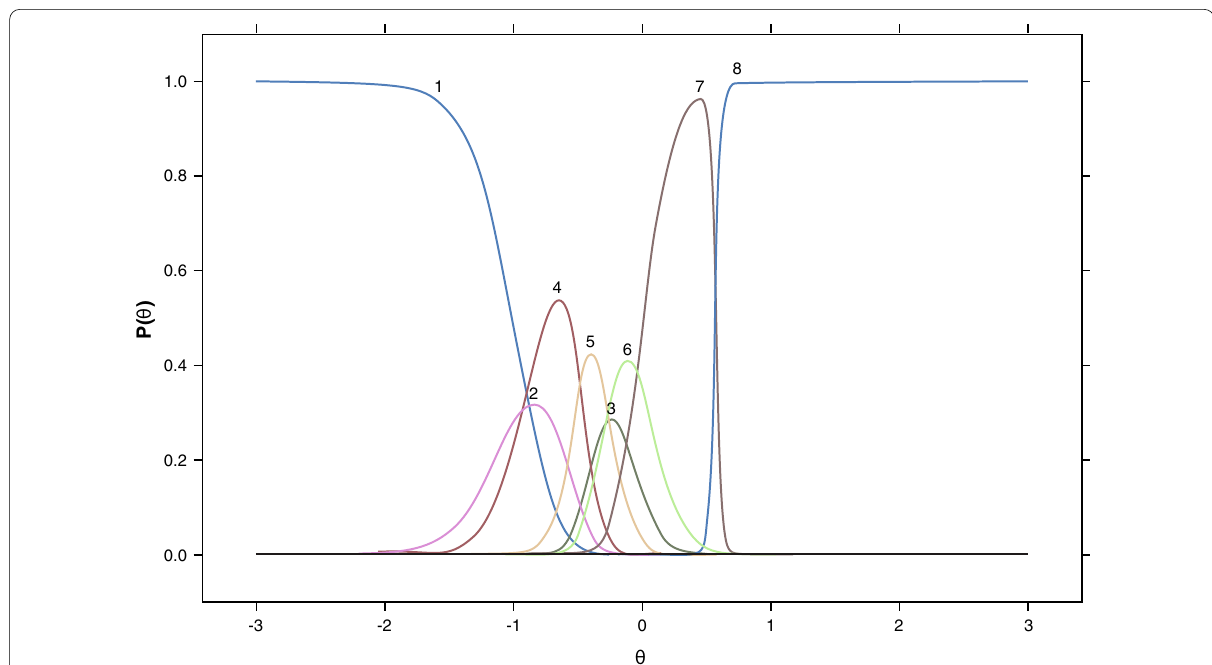
Fig. 2 Nominal item characteristic curves for the Satisfaction Hour 1 and correspond to the testlet responses as defined in Table 4